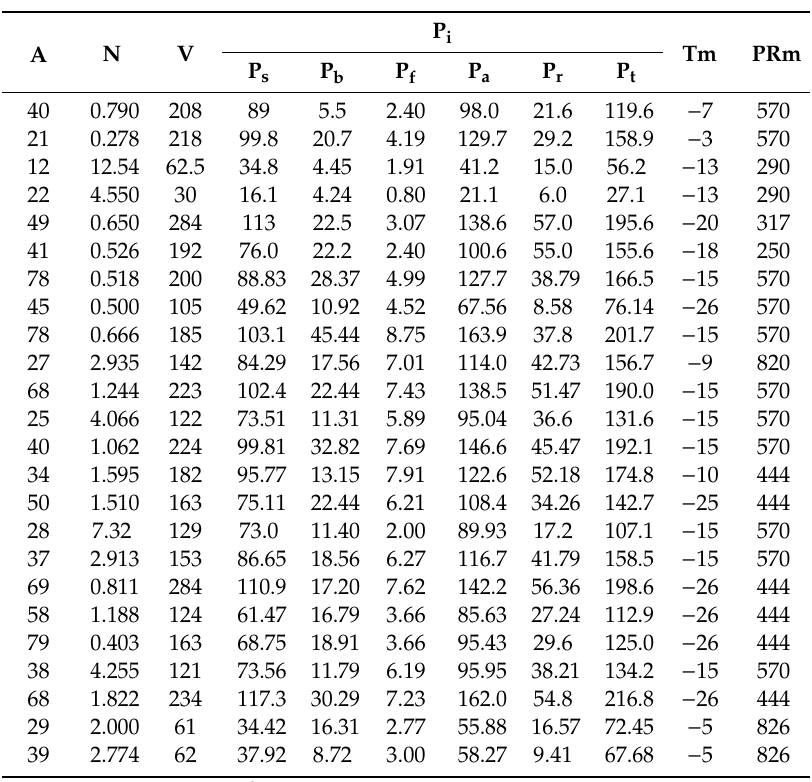
Table 2. A fragment of the original matrix of experimental data